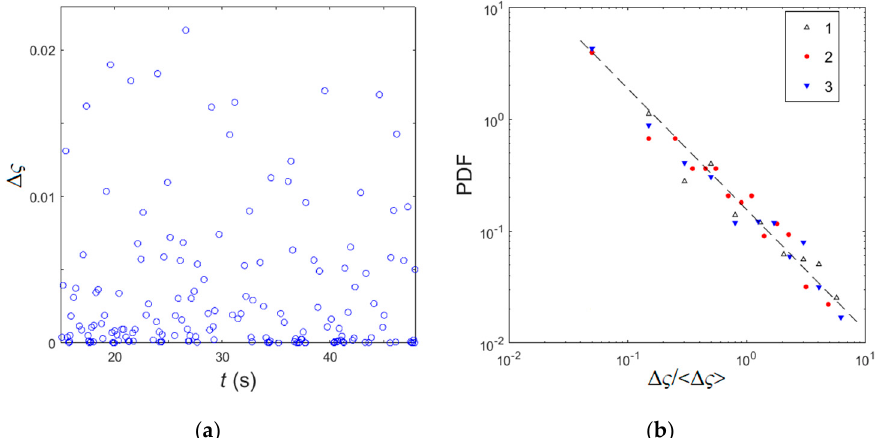
Figure 2. Example of processing of stress serrations. ( a ) Scatter of normalized values of stress serrations, ∆ ς , in a time interval corresponding to a stabilized jerky flow for one of the samples. ( b ) Examples of probability density functions (PDF) of ∆ ς serrations for three samples. A dashed line is traced as a guide for the eye to show the slope β of the power-law distributions in log-log coordinates. The least-square evaluation renders the following mean and standard deviation for the estimates of β : 1—1.00 ± 0.07; 2—1.03 ± 0.07; 3—1.04 ± 0.06.